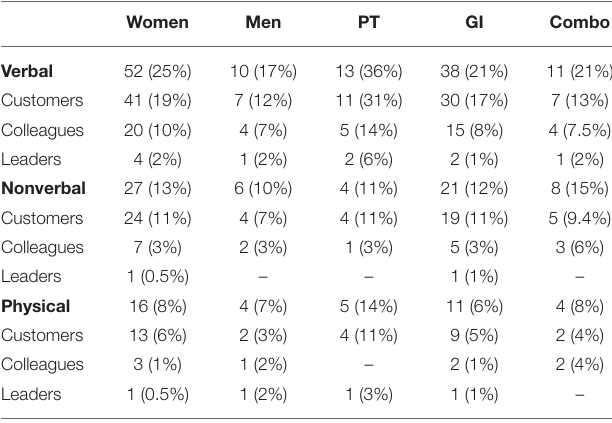
TABLE 2 | Sexual harassing (SH) experiences reported by participants, separated by sex and by profession, and the reported sources.